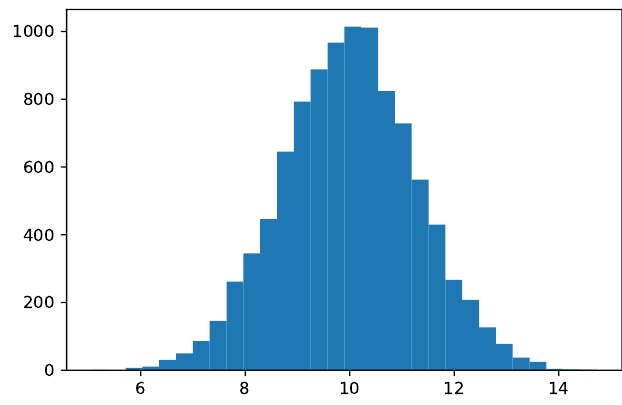
Fig. 95.— Histogram of 100000 values randomly drawn from a normal distribution or jpg, are possible. Resolution for pixel-based formats can be set using the option dpi=300 for 300 dots per inch, or similar. The bbox_inches=’tight’ makes sure the figure fits itself nicely into the allotted